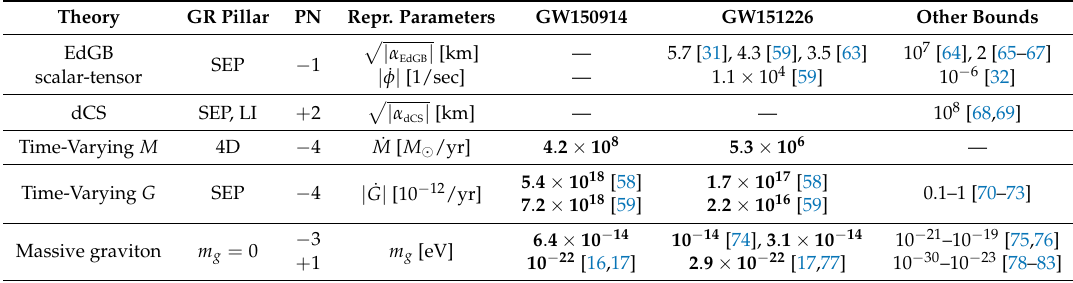
Table 1. Each example theory (1st column) violates certain fundamental aspects of general relativity (GR) (2nd column: the strong equivalence principle (SEP), Lorentz invariance (LI), four-dimensional spacetime (4D), and massless gravitons ( m g = 0)) and the leading correction enters in the gravitational waveform at certain PN orders (3rd column). Each representative parameter (4th column) has been constrained from GW150914 (5th column), GW151226 (6th column) and from other observations (7th column). The top (bottom) row within massive graviton corresponds to modifications in the dynamical (propagation/conservative) sector. This table is taken and edited from